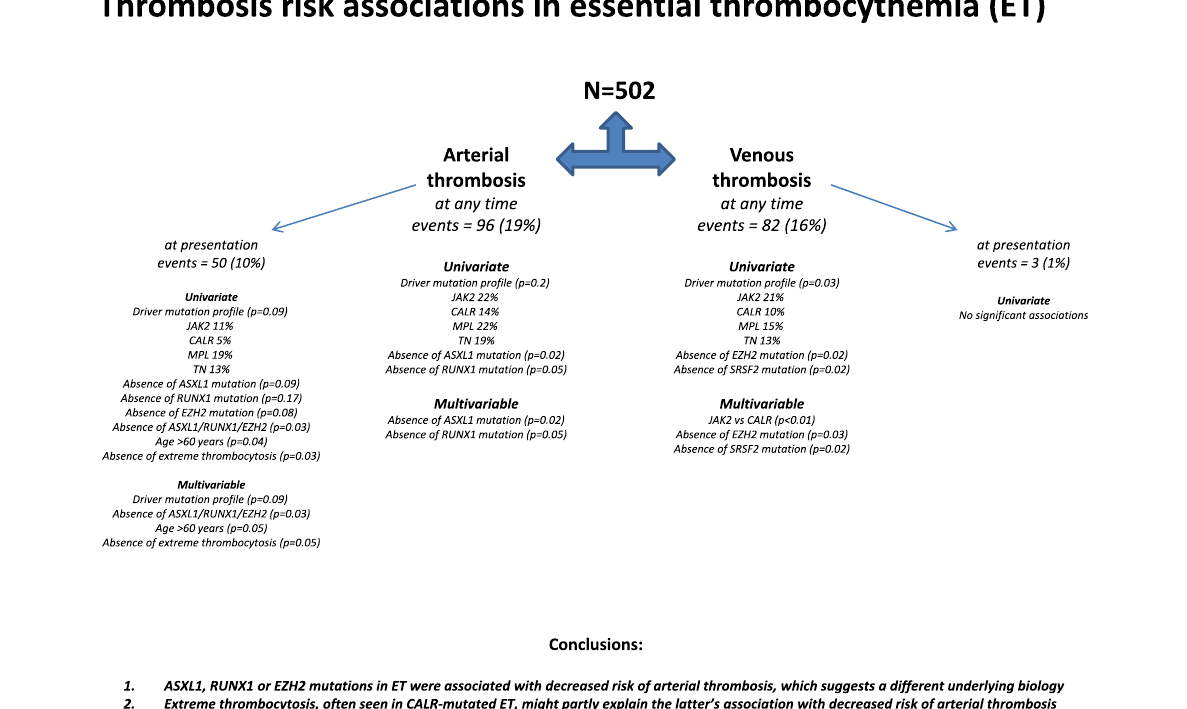
Fig. 1 Thrombosis risk associations in essential